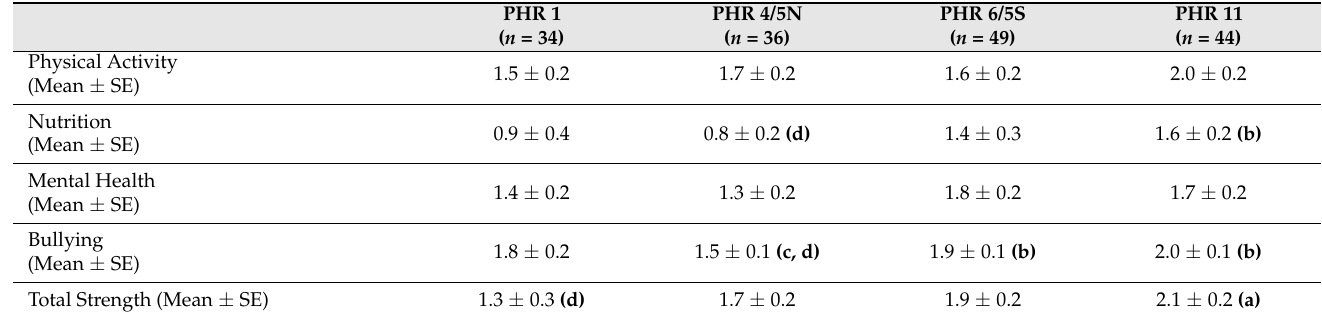
Table 4. CIPs ( n = 163) strength for each topic area by Public Health Region